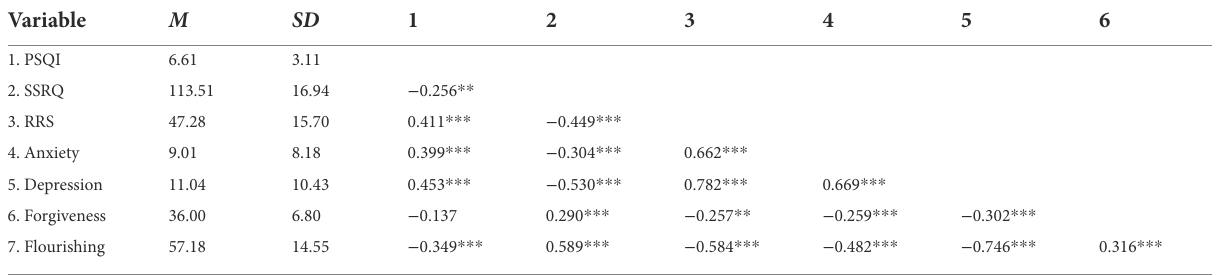
TABLE 1 Means, standard deviations, and correlations for sleep quality and quantity, and trait measures.